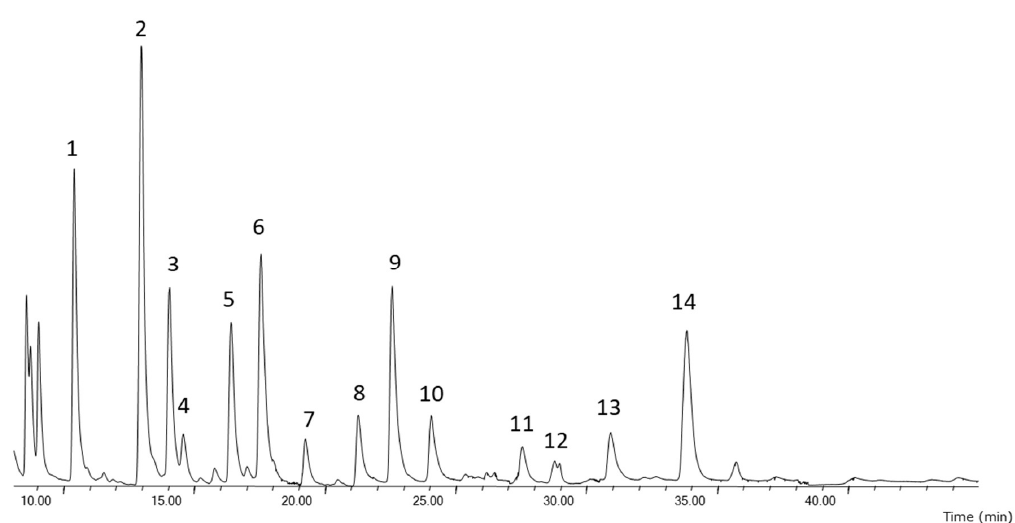
Figure 5. Fatty acid profile of microalgal lipid extracted with Folch traditional method determined by GC-MS. 1. C14: 0, 2. C16: 0, 3. C16: 1, 4. C: 17: 0, 5. C18: 0, 6. C18: 1, 7. C18: 2 n-6, 8. C18: 3 n-3, 9. C18: 4 n-3, 10. C20:4 n-6., 11. C20: 5 n-3, 12. Not identified (N.i.), 13. N.i., 14. C22: 6 n-3. Table 1. Fatty acid composition (as a percentage of total fatty acids) determined by CG-MS of microalgal lipid fractions at optimal extraction conditions. % Fatty Acids 1